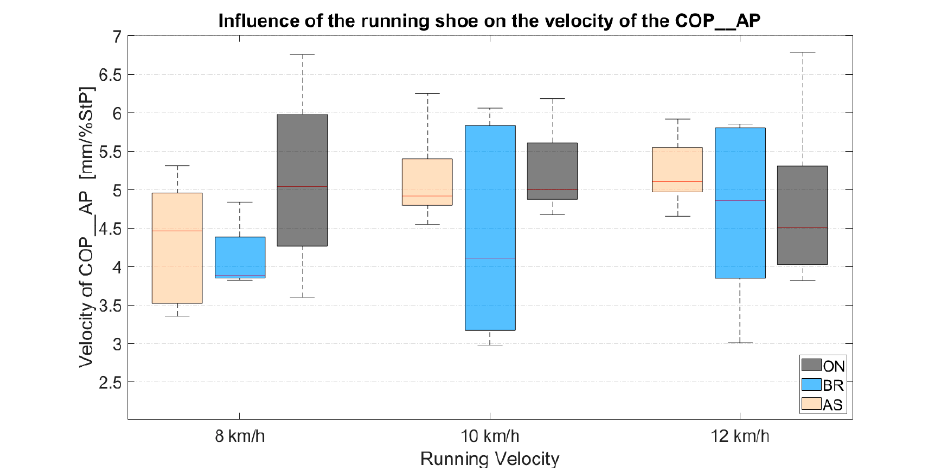
Figure 3. Results for the influence of the three running shoes on “ride” for all three tested running velocities. The horizontal axis lists the three running velocities (8, 10 and 12 km/h), and the vertical axis shows the “ride” in mm per % of the StP. The bright flesh-colored boxes represent the Asics GEL- NIMBUS 18, the blue boxes represent the Brooks Glycerin 14, the and dark grey boxes represent the On